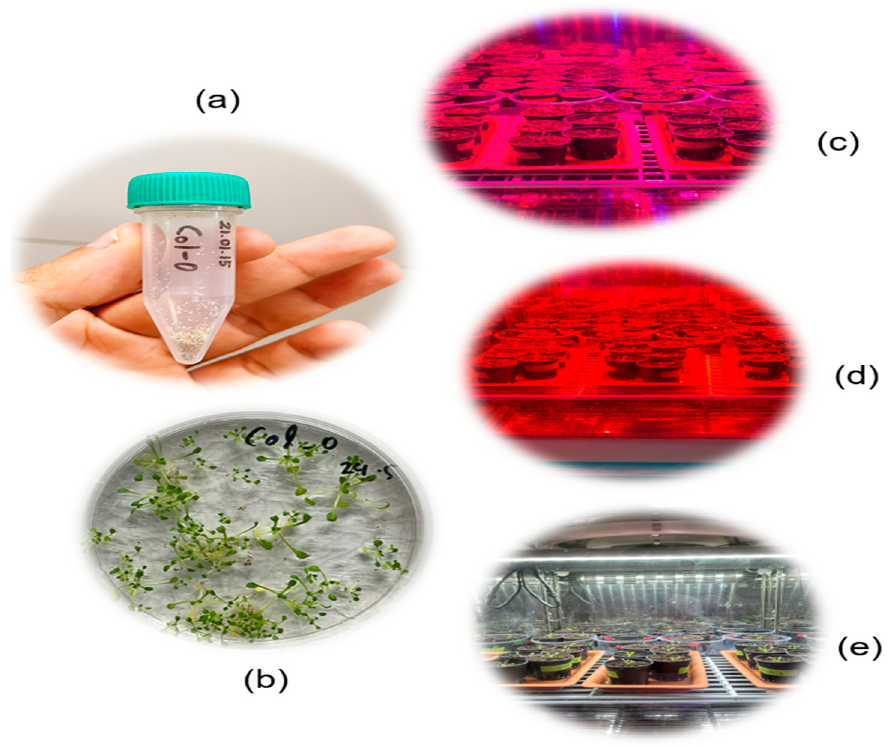
Figure 15. Arabidopsis Col-10 seeds ( a ), seeds grown in a Petri dish ( b ) under different lighting conditions: ( c ) red + blue, ( d ) red, and ( e ) white.